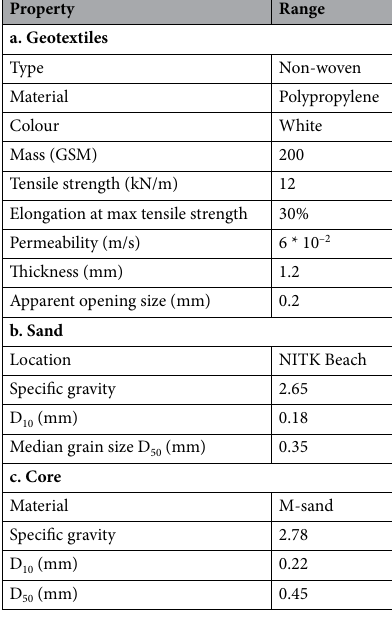
Table 3. Properties of construction materials used.